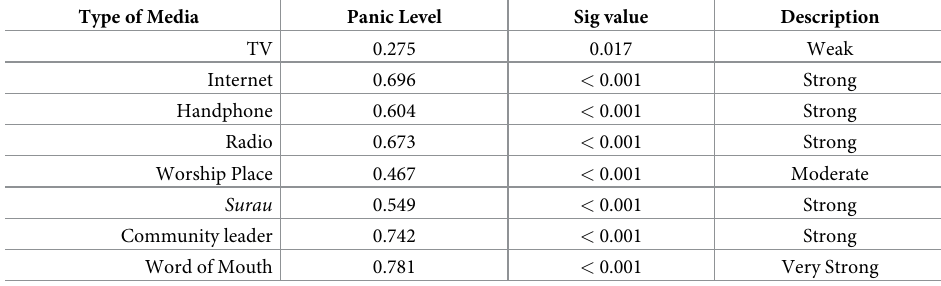
Table 6. The relationship between types of disaster information source media and panic level of affected commu- nity in Sigi